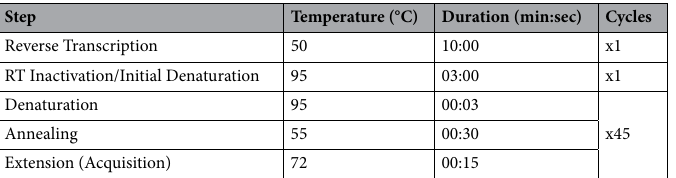
Table 2. RT-qPCR Cycling conditions. Acquisition of FAM: 510–530 nm; HEX: 560–580 nm; ATTO647 (Cy5 channel): 675–690